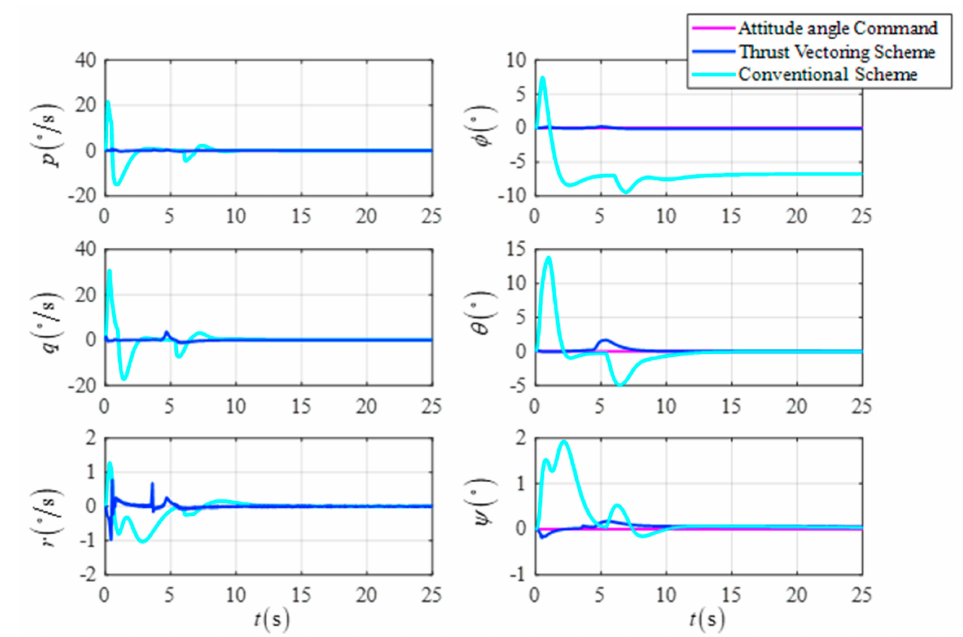
Figure 14. The attitude angle and the attitude angular velocity in landing.